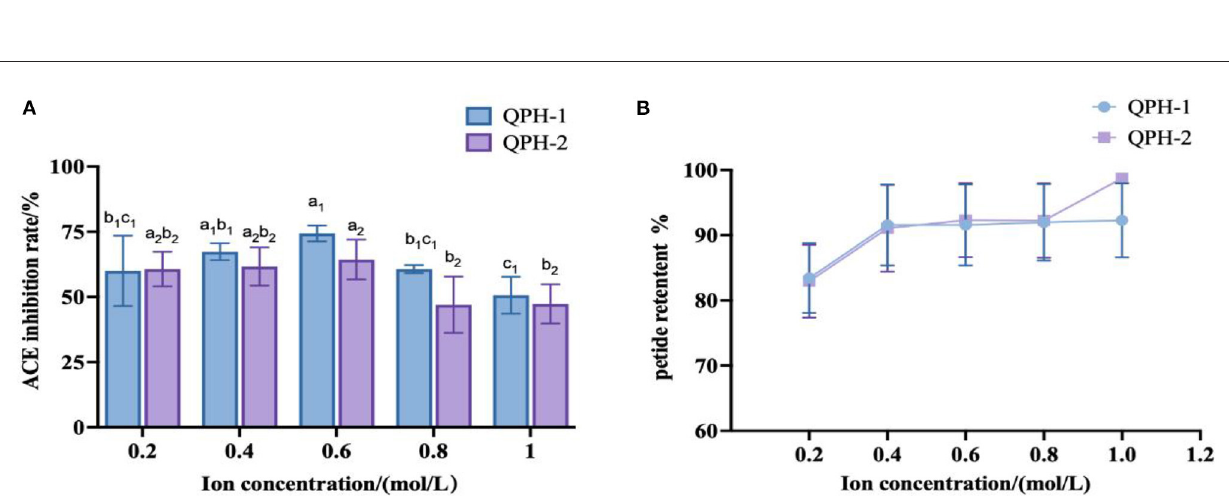
( p < 0.05). The proportion of polypeptides with mass above 5